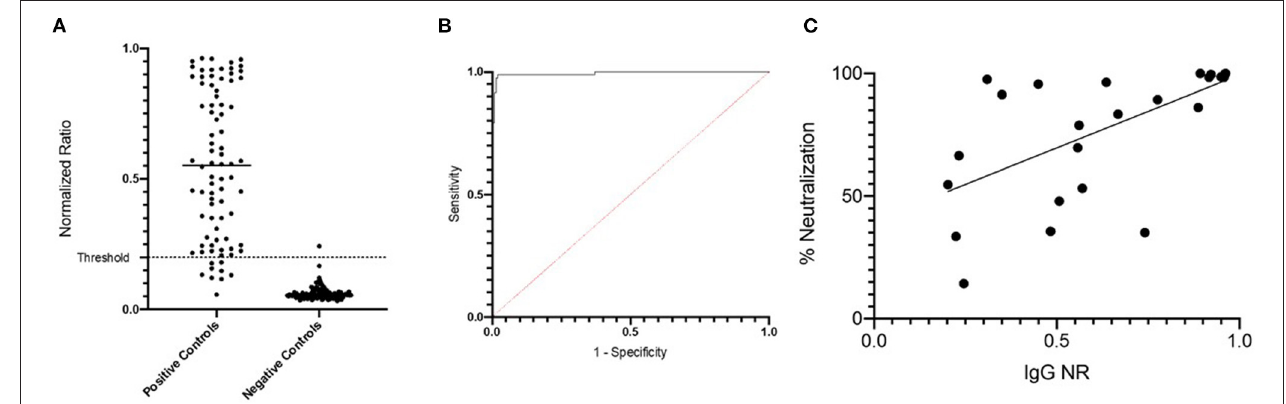
FIGURE 1 | Development and validation of RBD ELISA to detect human SARS-CoV-2-specific IgG. (A) Positive and negative control specimens were tested by the RBD ELISA. The normalized ration (NR, see methods) is plotted on the y-axis. The horizontal dashed line at NR = 0.2 indicates the assay cut off as determined by ROC curve analysis shown in (B) . (C) NR values from the RBD ELISA are plotted (x-axis) against the percent neutralization determined in a screening assay performed at a single dilution (1:30). The screening assay quantifies the amount of pseudovirus infection in the presence of test sera relative to pseudovirus only wells. Values < 50% are considered a negative screening test for SARS-CoV-2 neutralizing antibodies.